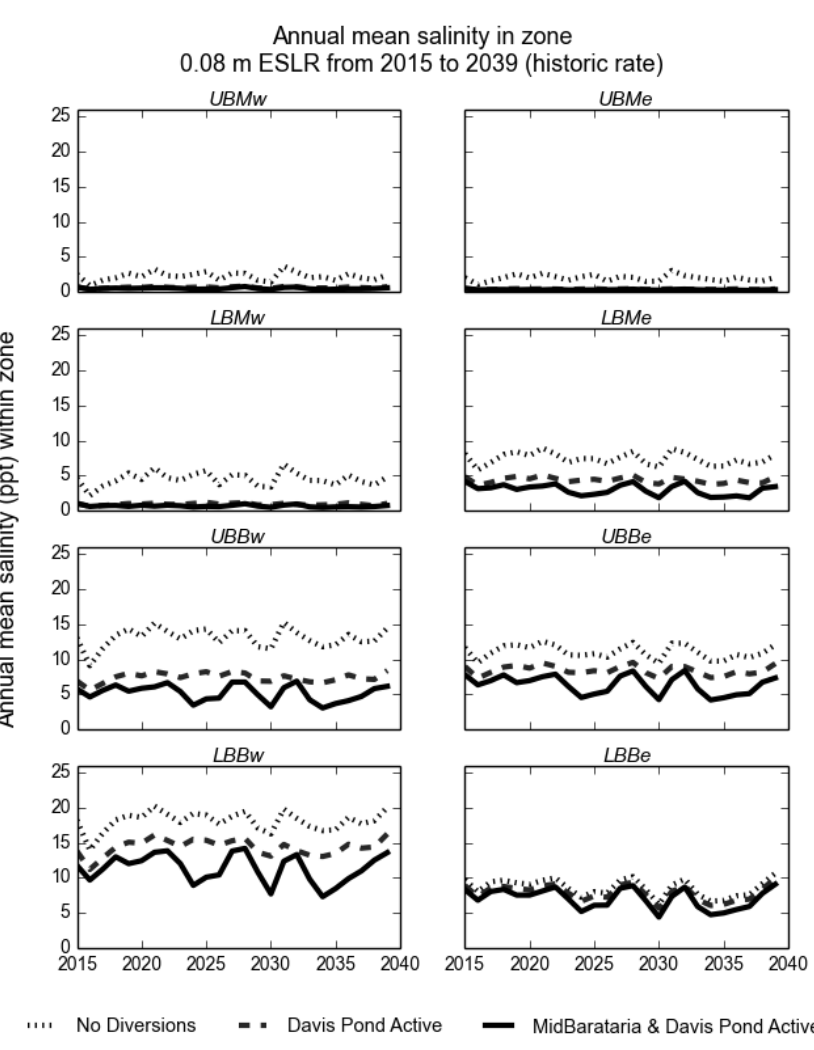
Figure 11. Annual mean salinity by zone for three simulations under historic sea level rise rates: no diversions active (dotted), Davis Pond only (dashed), and both Davis Pond and Mid-Barataria diversions active (solid).